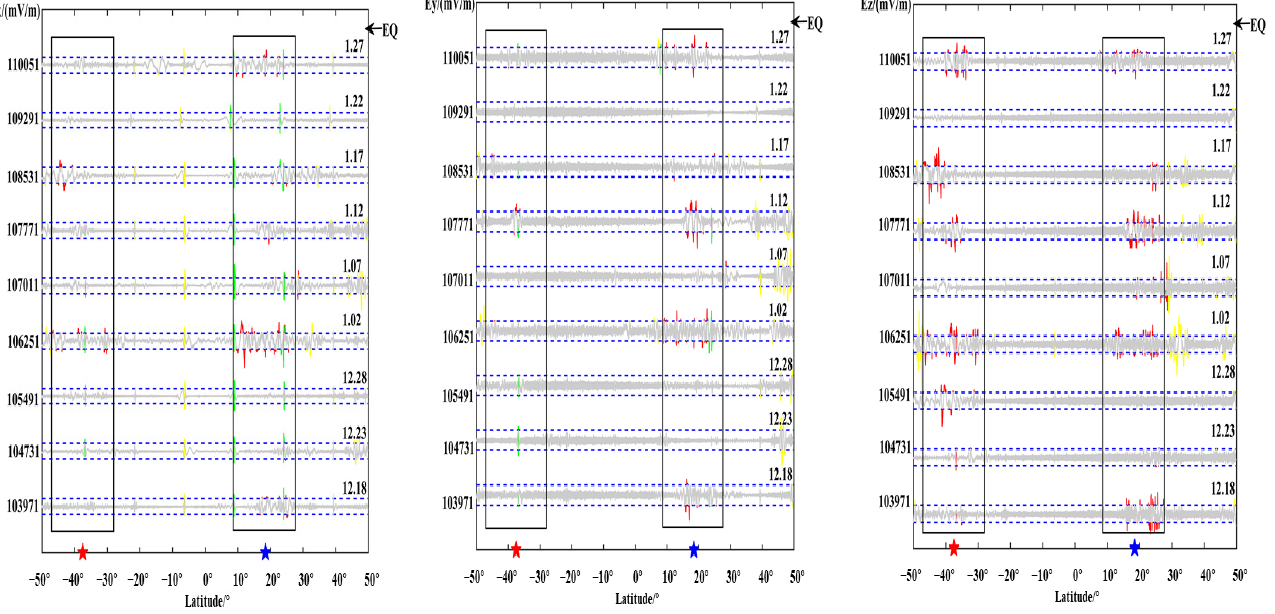
Figure 9. Orbit 110 , 051 and its revisited tracks. Figure 9. Orbit 110,051 and its revisited